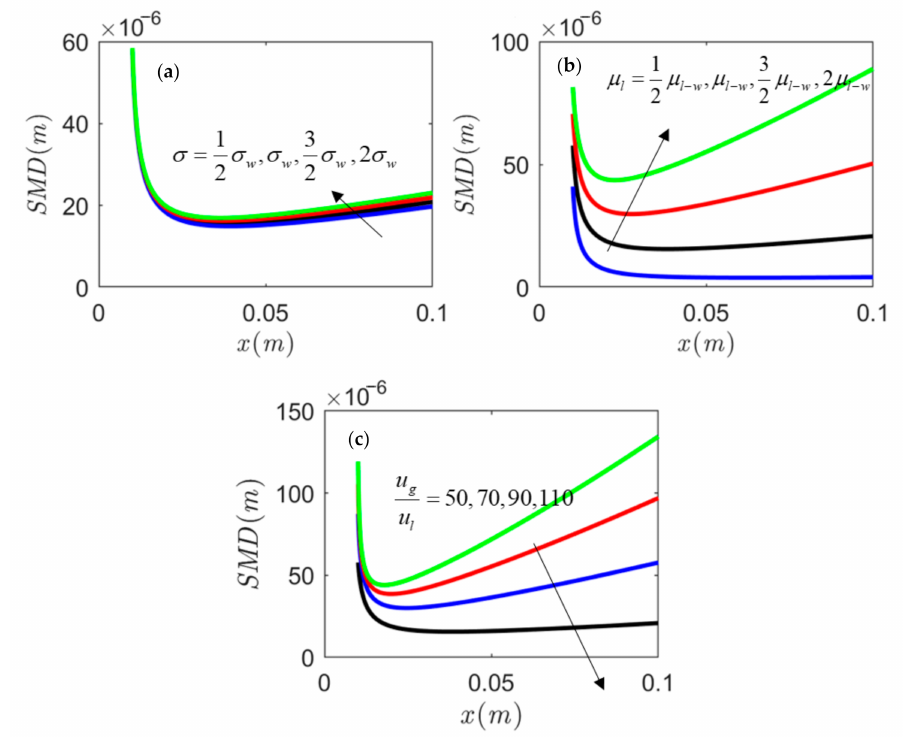
Figure 8. Impacts of formulation properties, σ and µ l , and injection point gas and liquid velocity ratios, u g / u l , on SMD (shown in ( a – c ), respectively). In the top panels, u g = 125 and u l = 2.5 m / s. Arrow directions show the incremental